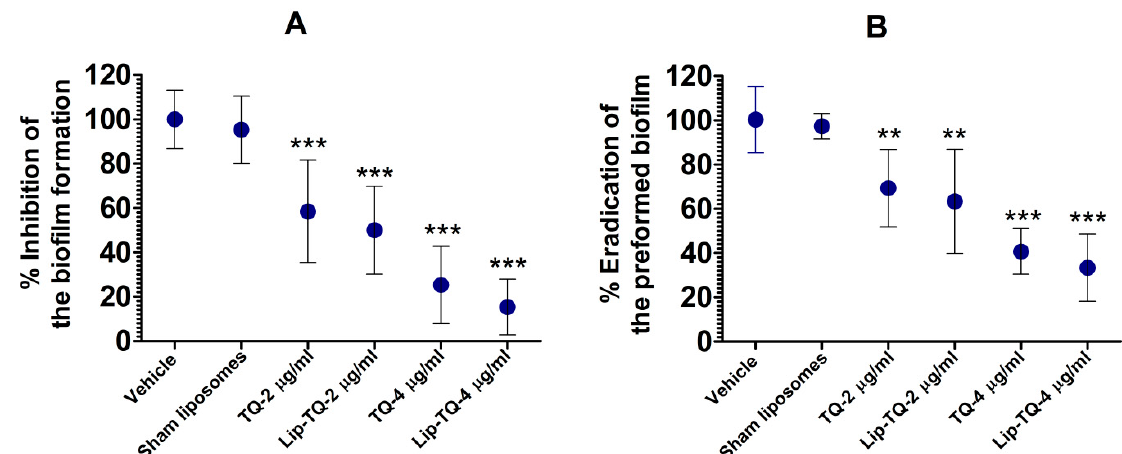
Figure 1 . The effect of free TQ or Lip-TQ (2 and 4 µg/mL) against ( A ) biofilm formation and ( B ) preformed biofilm by A. baumannii . A p value <0.05 was considered to be significant. ** ( p < 0.01), *** ( p < 0.001) free TQ vs. vehicle treatment, Lip-TQ vs. sham liposomes treatment. The data are represented as the mean ± SD of three independent values. The data were analyzed by one-way ANOVA followed by the Turkey post-test.